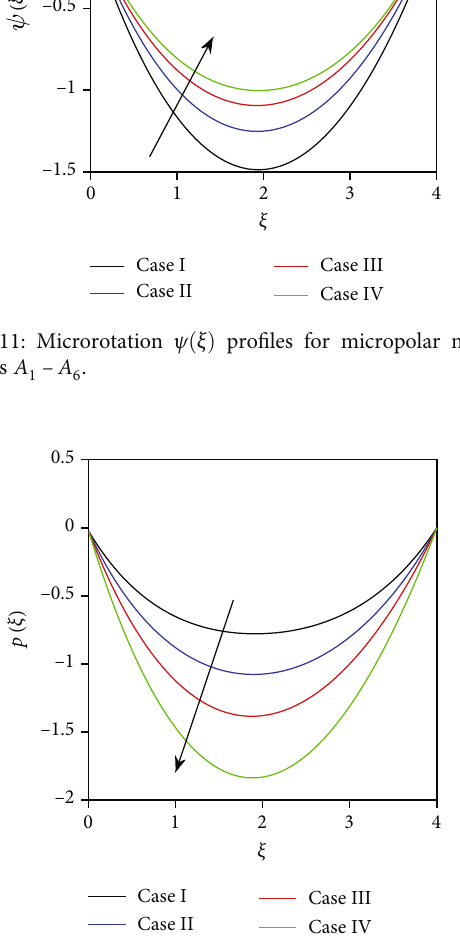
Figure 12: Microrotation p ð ξ Þ pro fi les for micropolar material constants A 1 – A 6 .